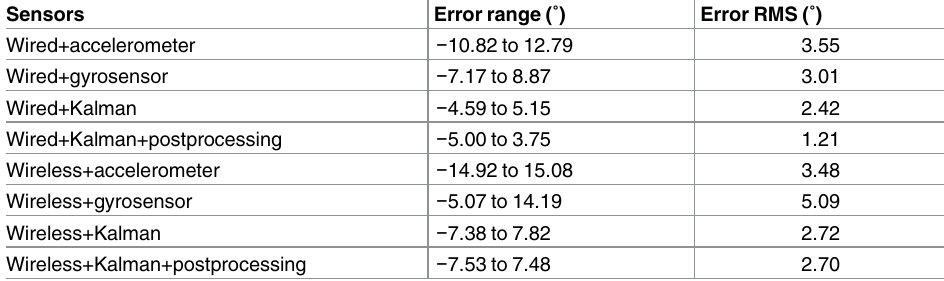
Table 1. Error of rotational angle with different combinations of sensors, connections, and process- ing. Error was definedas the difference betweenthe measuredrotationalangle and the opticalrotational angle. RMS, root mean square; Kalman,